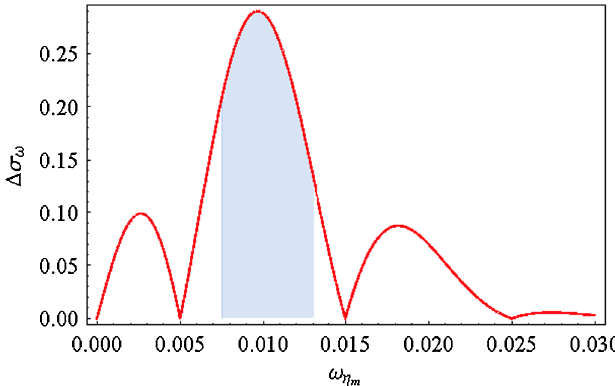
ð z Þ as a function of !